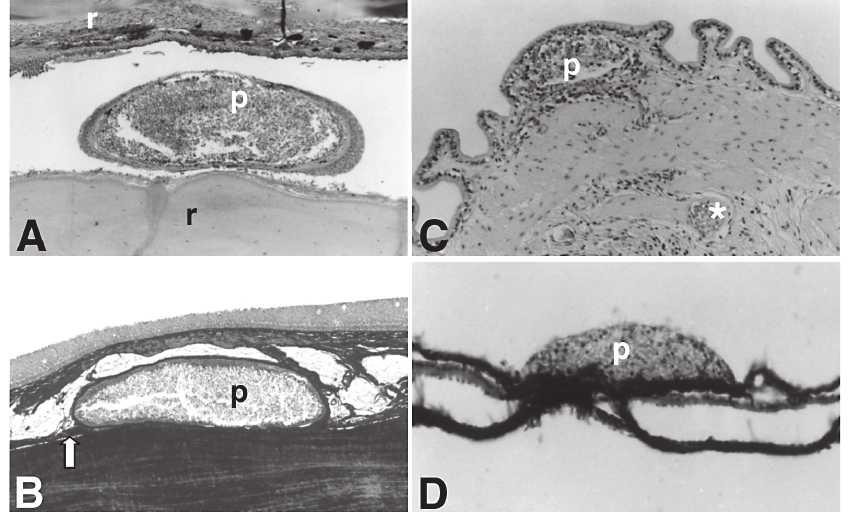
Fig. 2. – Light photomicrographs of histological sections of gills of Piaractus mesopotamicus infected with Myxobolus cuneus n. sp. Sirius red staining. A - plasmodium in the arterioles wall of the gill filament (p). 260 × . B - agglomerate of plasmodia (p) producing obs- truction of the arteriole lumen (L). Note the capsule of connective tissue (arrow). 1960 × .